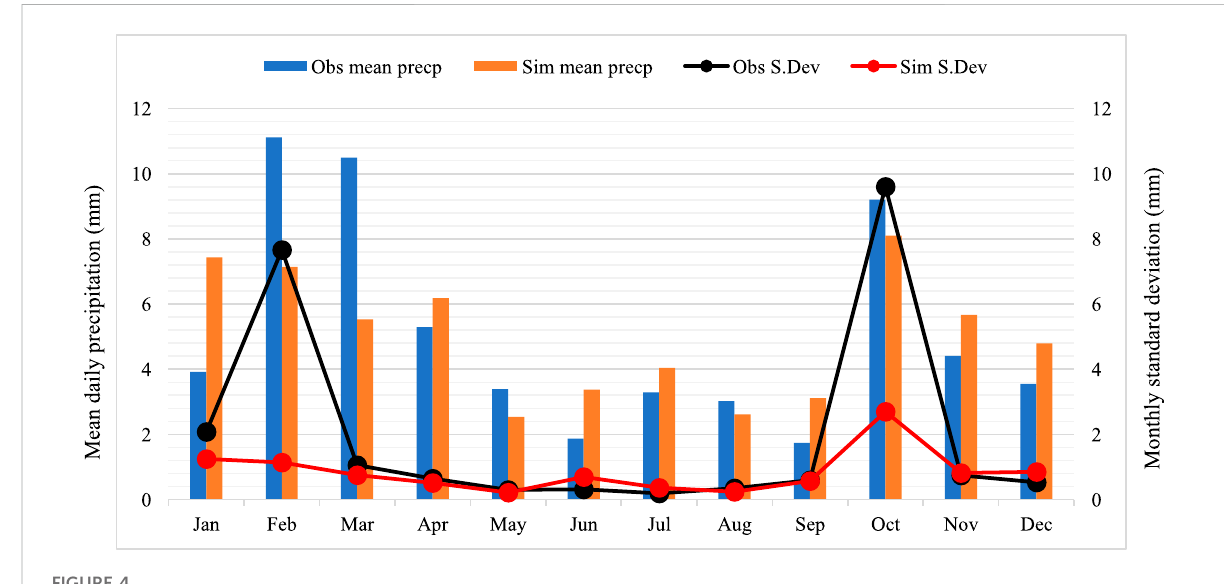
FIGURE 4 SDSM validation of observed and simulated areal precipitation characteristics.